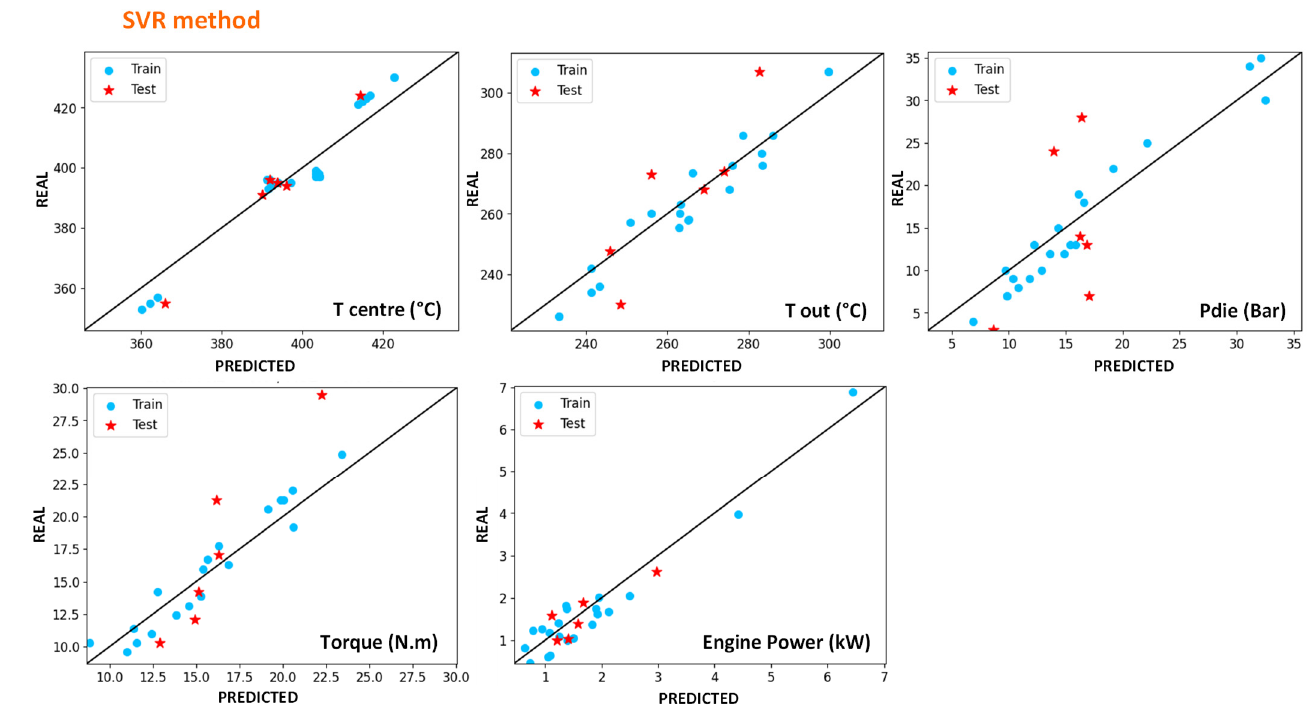
Figure 10. Results of the outputs predicted by the SVR method versus the experimental ones. The blue dots correspond to training data, and the red stars correspond to test data for HDPE and UHMWPE indiscriminately.